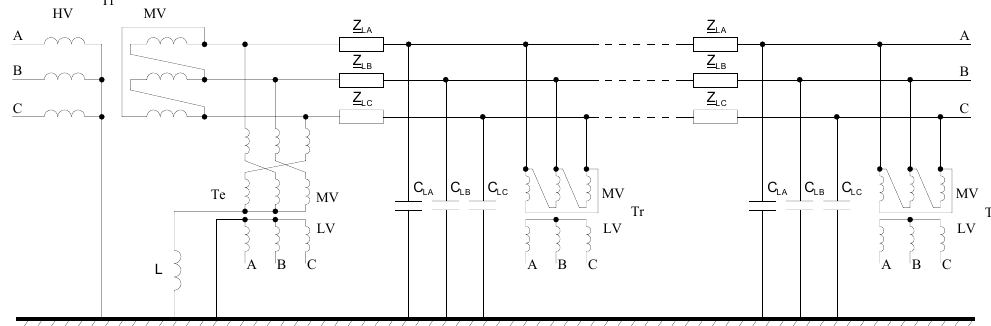
Figure 3. Equivalent model of MV power network with neutral point earthed by inductance (earth fault compensation). HV—high voltage, MV—medium voltage, LV—low voltage,, Tf—feeder transformer, Tr—receiving transformer, Te—earthing transformer, L—neutral point earthing inductance, Z LA , Z LB , Z LC —longitudinal impedances of MV line in individual phases, C LA , C LB , C LC —shunt capacitance of MV line in individual phases.